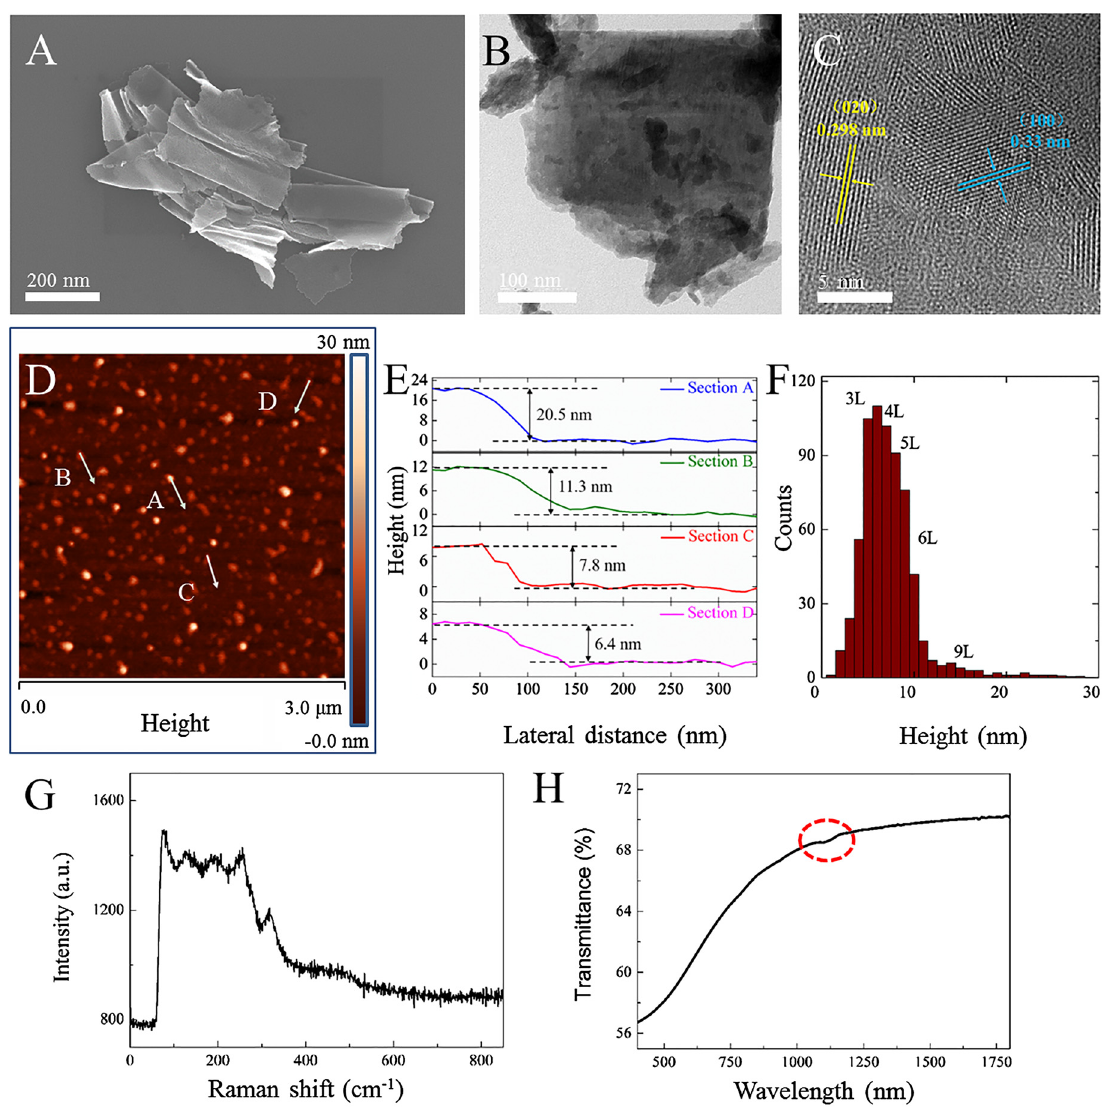
Figure 1: Material characteristics of the layered franckeite. (A) Scanning electron microscope (SEM) micrograph of layered franckeite after liquid-phase exfoliation (LPE). (B) transmission electron microscopy (TEM) image of layered franckeite. (C) The corresponding atomic scale high-resolution TEM (HRTEM) of an ultrathin franckeite layer.(D)Two-dimensional topographical atomicforcemicroscopy(AFM) imageof franckeite fi lm.(E)Height pro fi lesof thesectionsmarkedin Figure 1D. (F) Statistical analysis of the AFM raw height data. The inserted numbers prove that the nano fl akes from ∼ 3 layers (3L) to ∼ 6L are more widely distributed (unit cell, H + Q layer, thickness 1.7 nm [20]). (G) Raman spectra of layered franckeite. (H) The linear transmittance of layered franckeite shows a small valley around 1.1 μ m